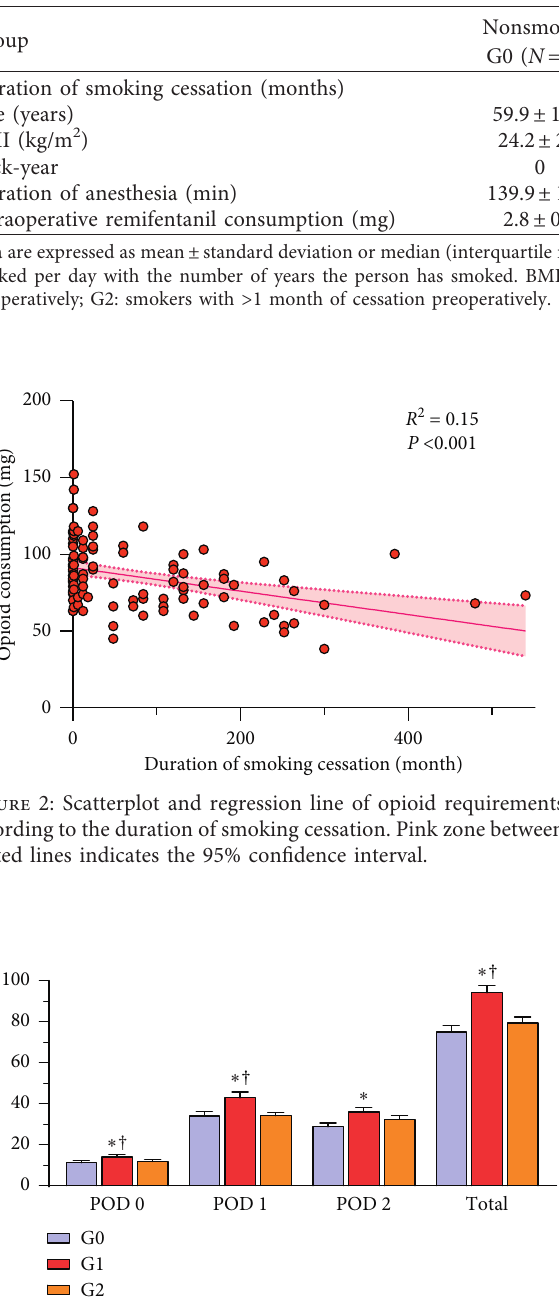
Table 1: Patients’ characteristics.